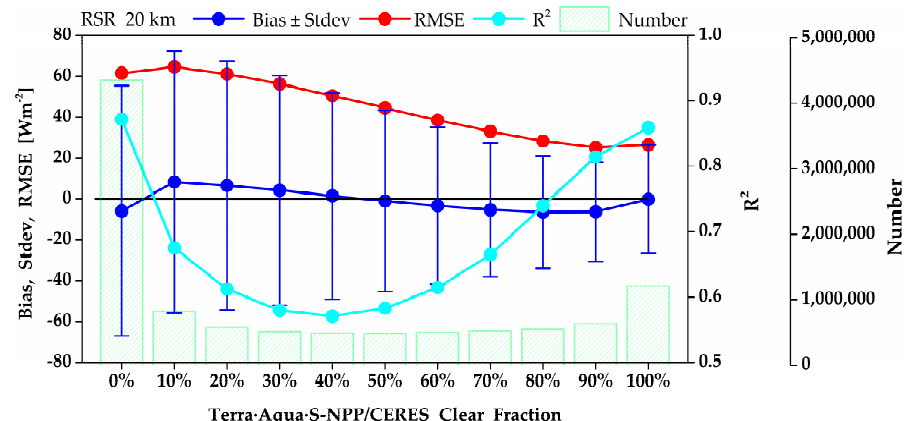
Figure 7. Coefficient of determination (R 2 ), standard deviation (Stdev), Bias, and RMSE of RSR using Himawari-8/AHI and Terra, Aqua, and S-NPP/CERES for the clear fraction for all cases. The bar graph shows the number of data. Table 4. Statistical analysis of RSR retrieval results according to land, ocean, and clear fractions (all: 0–100%; partly cloudy: 50–95%; mostly cloudy: 5–50%; overcast: < 5%). Statistics Clear Fraction Land & Ocean